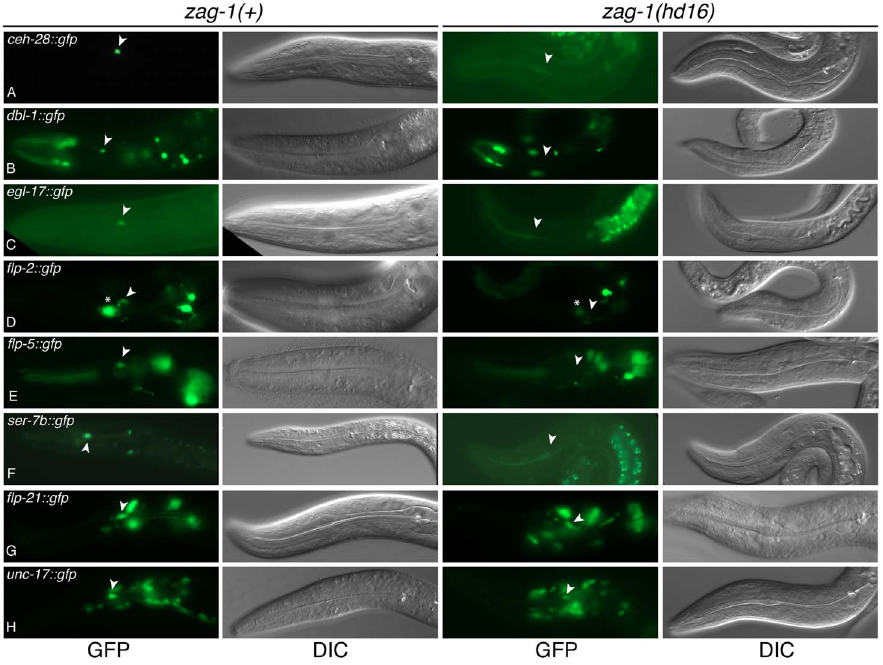
Figure 3. Expression of M4 differentiation markers in zag-1(hd16) mutants. Fluorescence (left) and DIC (right) micrographs of transgenic L1-L2 animals bearing ceh-28::gfp (A), dbl-1::gfp (B), egl-17::gfp (C), flp- 2::gfp (D), flp-5::gfp (E), ser-7b::gfp (F), flp-21::gfp (G), unc-17::gfp (H) in a zag-1( + ) or zag-1(hd16) mutants. The position of M4 is marked (arrowheads). Asterisk indicates flp-2::gfp expression in the MC neuron (D).